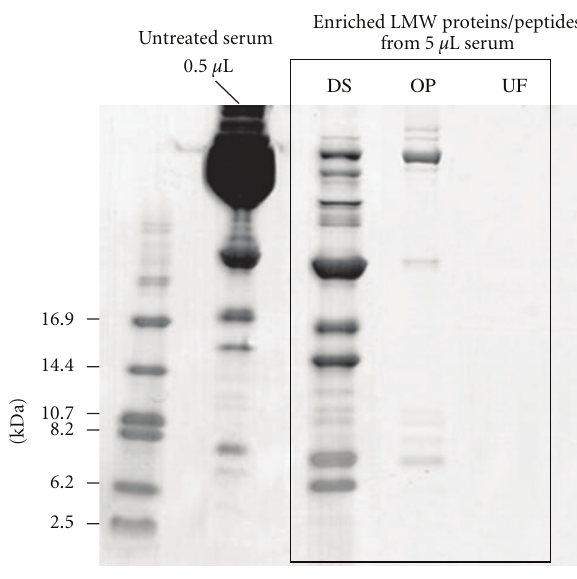
Figure 3: Comparison of the yield of low molecular weight protein/peptide extraction from serum by means of di ff erential solubilization (DS), organic precipitation (OP), and ultrafiltration (UF). All techniques e ff ectively remove the high molecular weight serum protein, whereas recovery of LMW proteins/peptides is highest with DS. Reprinted with permission from Kawashima et al. [94]. Copyright 2011 American Chemical